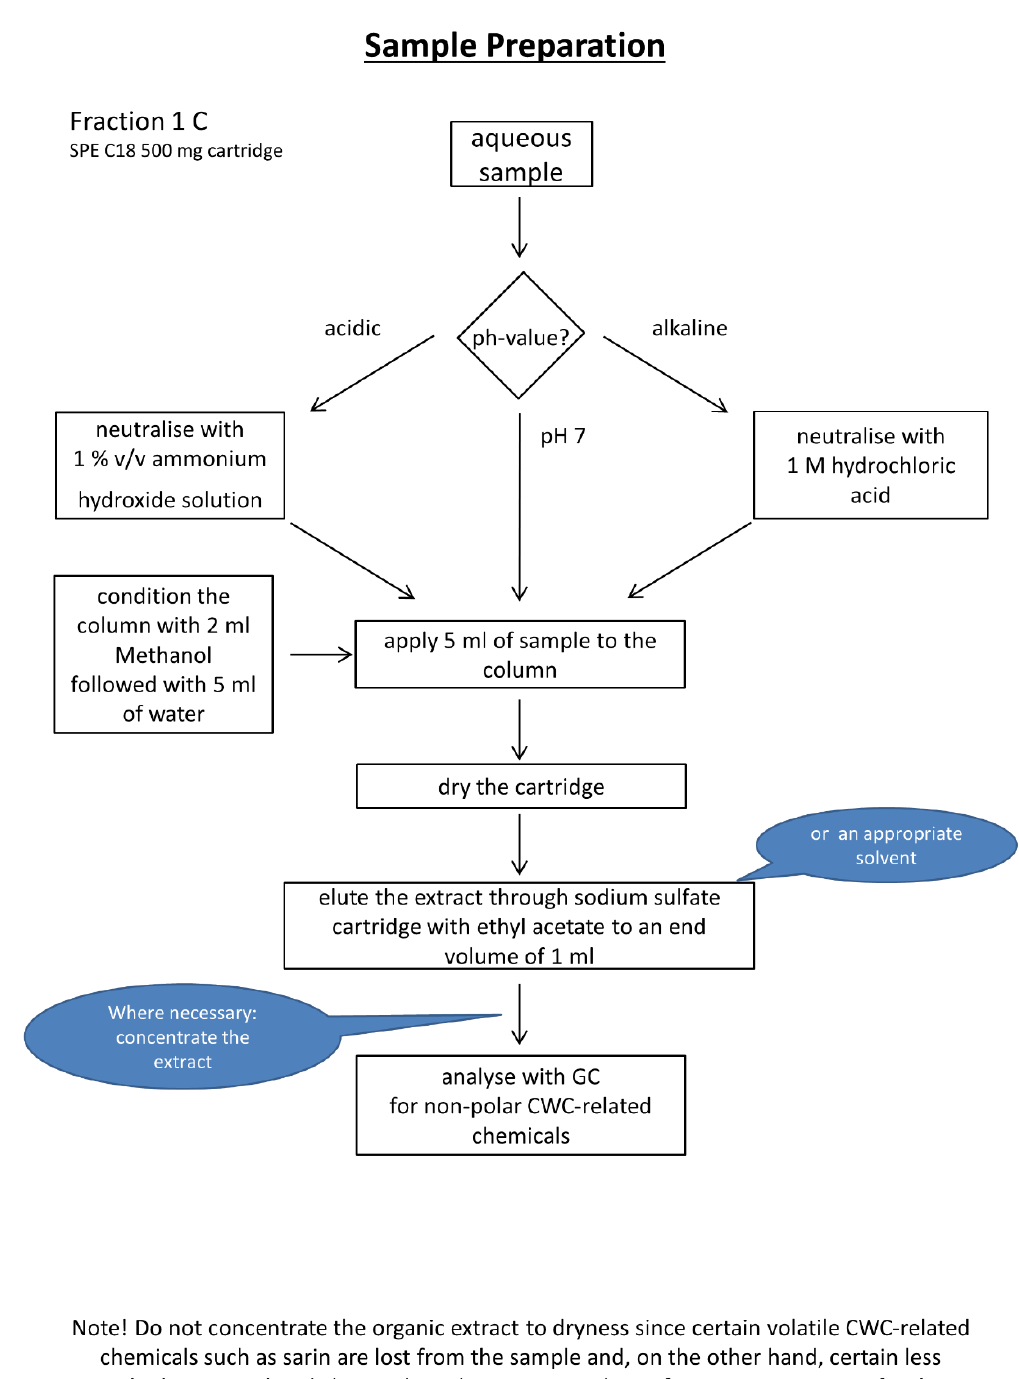
Figure A3. Recommended operating procedure according to the blue book for the processing of solid-phase extraction by C18-sorbent at neutral conditions.